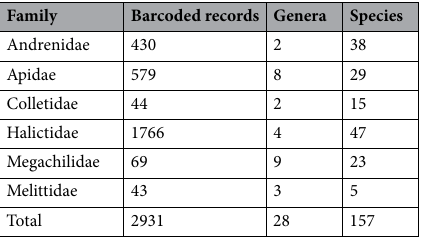
Table 1. Number of barcoded records, genera and species collected for the six bee families in our sampling.